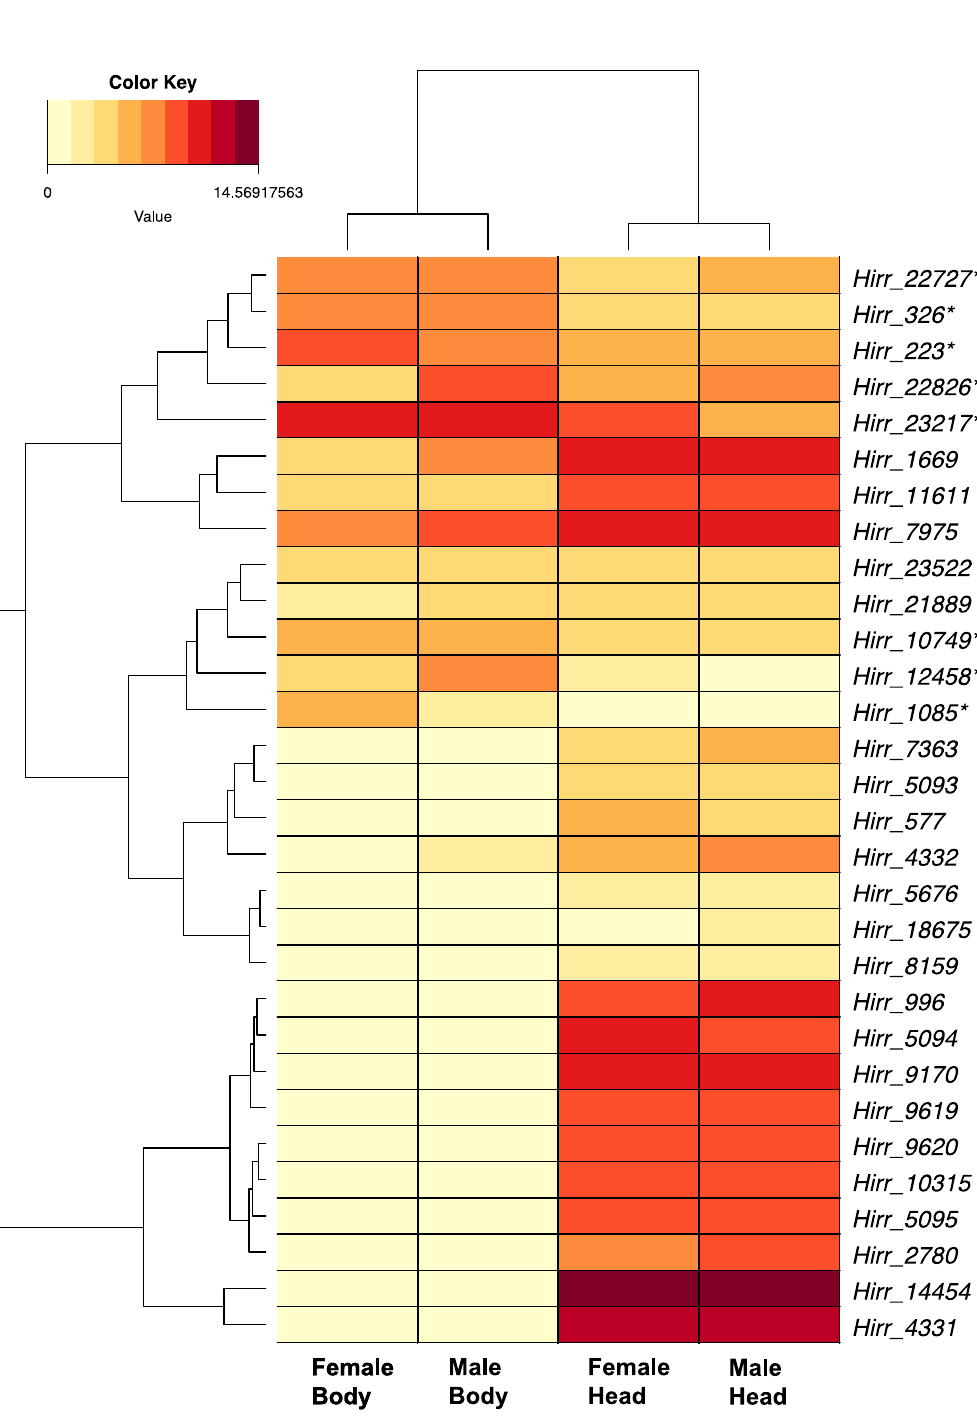
Figure 4. Heat map and hierarchical clustering dendrogram of Haematobia irritans candidate OBP transcripts in female and male head appendages (Head) and headless bodies (Body). Log-transformed TPM values were used to construct the heat map. OBPs expressed significantly higher in bodies versus head appendages are identified by an asterisk (*). Thirteen candidate OBP transcripts are not depicted, as they had relatively low expression values. Dendrogram reflects transcripts with similar expression patterns, identified by hierarchical clustering applied to expression values (rows) and dataset categories (columns).